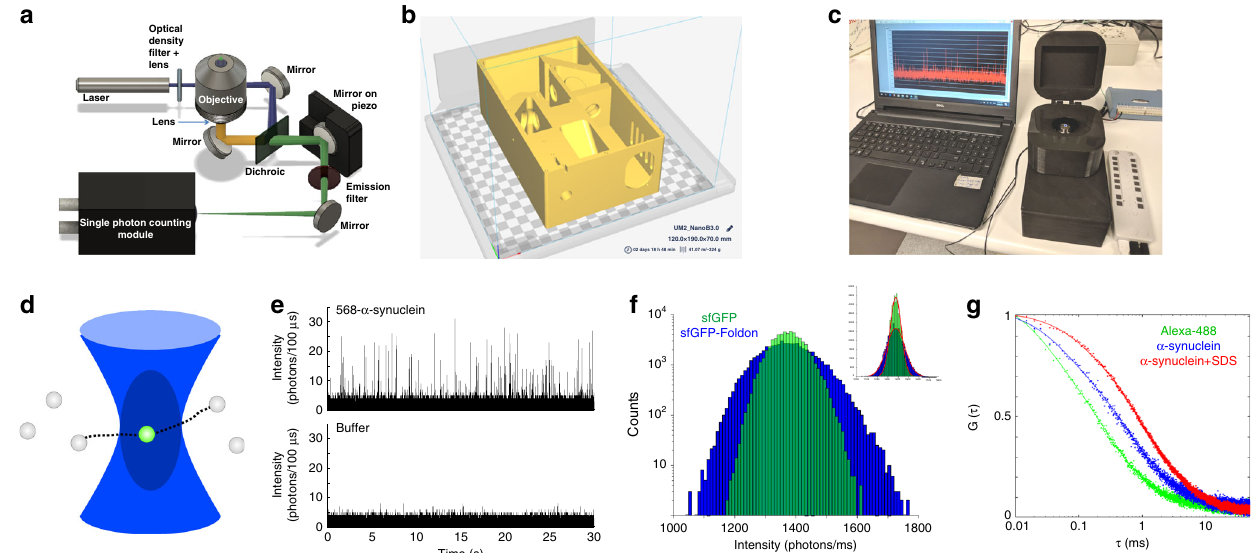
Fig. 1 Design and characterisation of 3D-printed confocal microscope. a Overview of optical path. The design utilises a single excitation laser, which is focused to a very small (femtolitre) observation volume using a water-immersion objective (Zeiss × 40 or × 63, 1.2 NA). The emitted fl uorescence is separated from the excitation fl uorescence using a dichroic mirror and further fi ltered before detection by a single photon avalanche photodiode (SPAD, Micro Photon Devices). b 3D design of the housing for 3D printing; mirrors are pre-aligned within housing and fi lters, dichroic, and laser line can be easily exchanged. c Photograph of microscope compared with a laptop. d Principle of confocal detection of individual molecules freely fl oating in solution. e Detection of individual α -syn molecules labelled with Alexa-568 in water (top) compared with water alone (bottom). These measurements were performed on a normal wet bench, in broad daylight. 532 nm excitation, acquired at 10 kHz for 30 s. f Photon counting histograms (450 nm excitation, acquired at 1 kHz for 30 s) of sfGFP (green) and sfGFP-foldon (blue), an sfGFP-tagged trimerisation domain. f Data from main fi gure fi t to Gaussian distribution for N&B analysis, see main text. g Fluorescence correlation spectroscopy (average of 8 × 10 s traces acquired at 1 MHz) of a fl uorophore with a known diffusion coef fi cient (Alexa-488, 10 n M , green) and 10 n M Alexa-488 labelled α -syn in the absence (blue) and presence (red) of 10 m M sodium dodecyl sulphate (SDS)